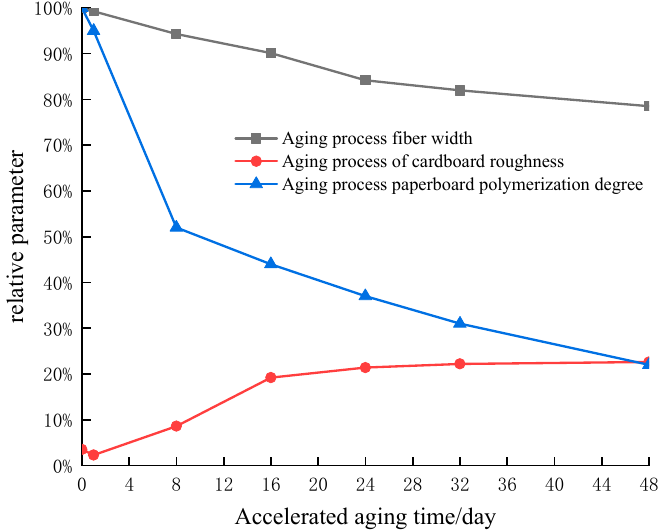
Figure 7. The trend of the various parameters during the aging process. The degree of polymerization of the insulating board reflects its aging degree, so the degree of polymerization of the insulating board is taken as the statistic to evaluate the aging degree of the insulating board. As can be seen from Figure 7, when the degree of polymerization is close to 500, which is approximately 50% of the degree of polymerization of the original board, the aging time can be roughly inferred to be approximately 14 days, the insulation life is only approximately half, and the corresponding fiber width is ap- proximately 37 µ m (91% of the width of the fiber without aging), and the corresponding roughness is 0.162. When the degree of polymerization is close to 250, which is approxi- mately 25% of the degree of polymerization of the original cardboard, it can be roughly inferred from Figure 7 that the aging time is approximately 45 days, which is close to the end of the insulation life. At this time, the corresponding fiber width is approximately 32 µ m (79% of the width of the non-aging cardboard fiber), and the corresponding roughness is 0.225. At the initial stage of aging, the fiber surface of the insulating board displays an “ablative” process, which may “ablate” the fibers on the surface of the insulating board [6], making the surface of the insulating board display a temporary smooth phenomenon (Figure 8b, degree of polymerization 993). With the extension of aging time, the fiber cell wall of the insulating paperboard begins to “peel” and display “crack silk separation”—cell wall displacement and deformation, where the outer layer of the primary wall and the secondary wall is broken and removed (Figure 8c, polymerization degree is 573). The fiber width decreases relatively, and a few holes appear on the surface (Figure 8d, polymerization degree is 469). A small amount of crystalline “solid” is accumulated (Figure 8e, degree of polymerization is 388), and the smoothness becomes worse. With the further aging of the insulating paperboard, part of the fibers began to break, and the fibers continued to be refined to produce more holes with a larger area than before (Figure 8f, degree